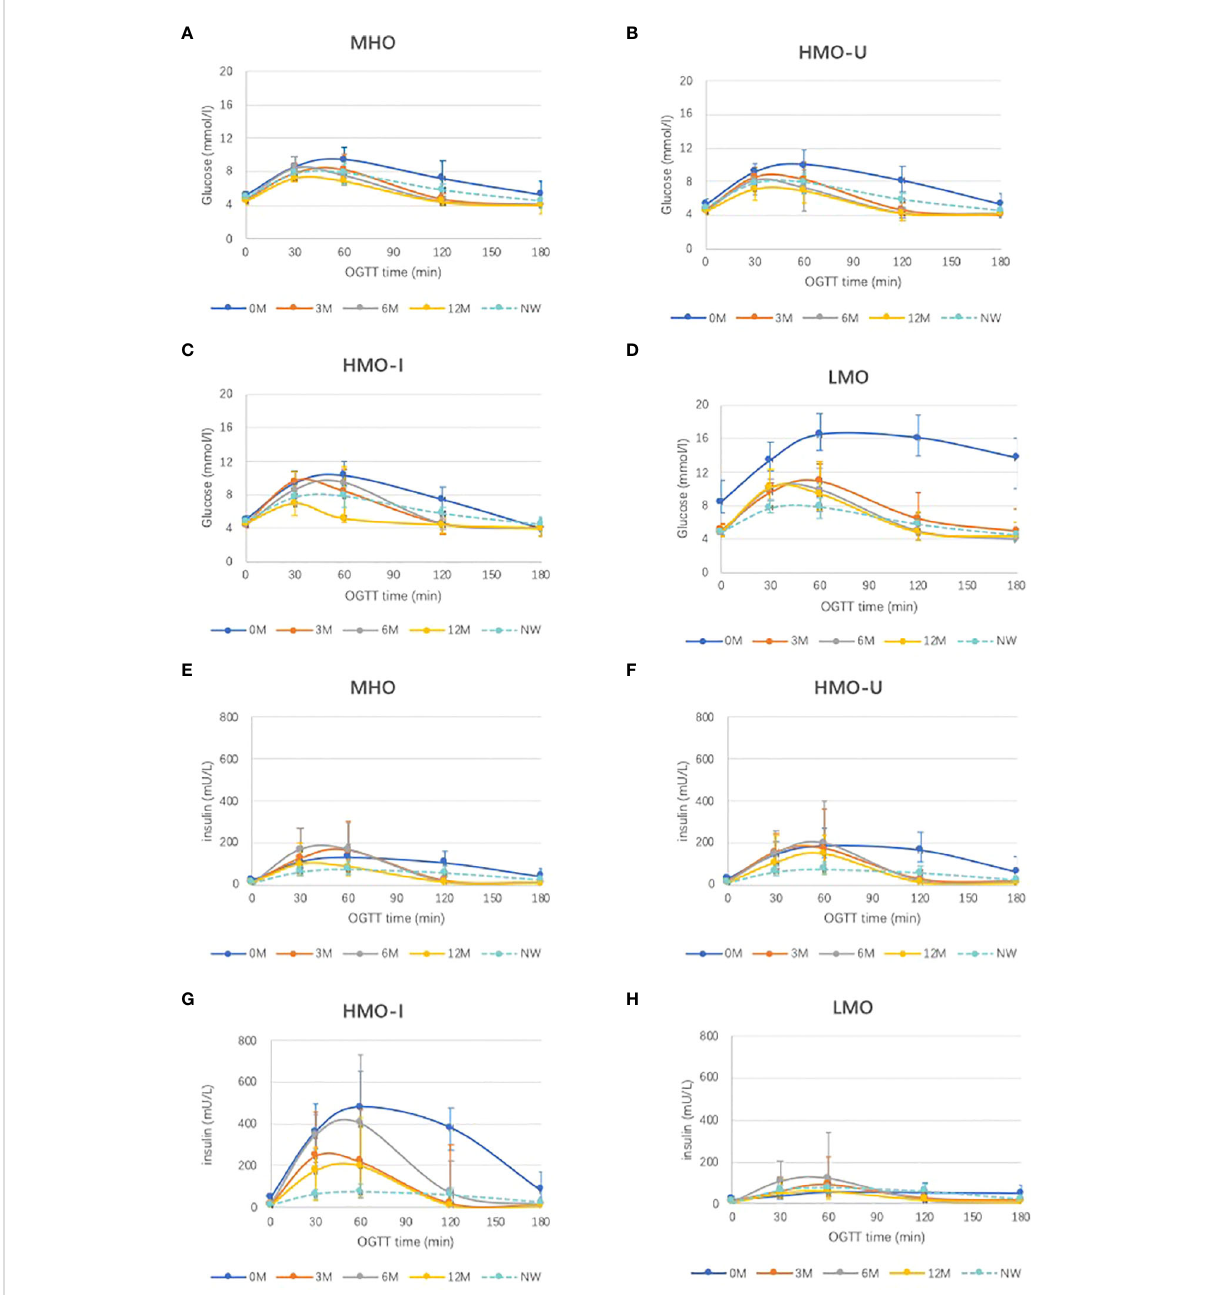
FIGURE 1 Comparison of different AIM subgroups of obesity and normal-weight controls for oral glucose tolerance test (OGTT) curves at baseline and post-surgery follow-ups. (A-D) , OGTT for glucose; (E-H) , OGTT for insulin. MHO, metabolic healthy obesity; HMO-I, hypermetabolic obesity hyperinsulinemia subtype; HMO-U, hypermetabolic obesity hyperuricemia subtype; LMO, hypometabolic obesity; NW, normal weight control; 0M, pre- surgery; 3M, 3-month post-surgery; 12M, 12-month